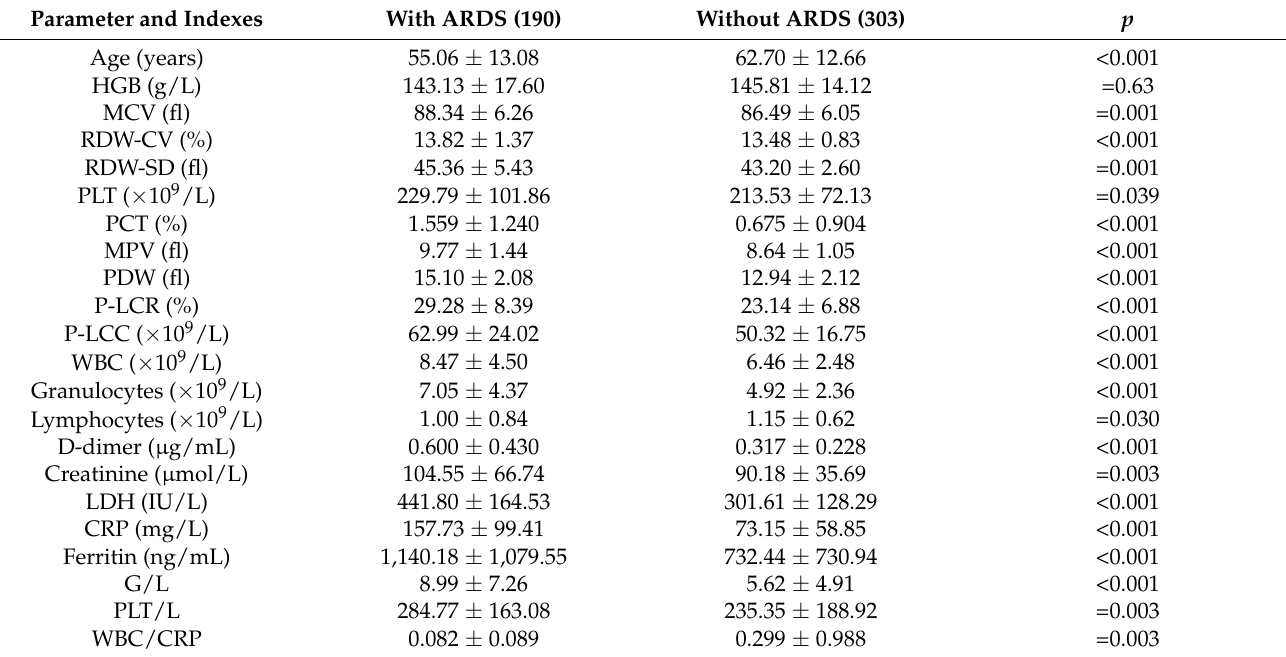
Table 1. Comparison of age and laboratory parameters with standard deviation between Group 1 with ARDS and Group 2 without